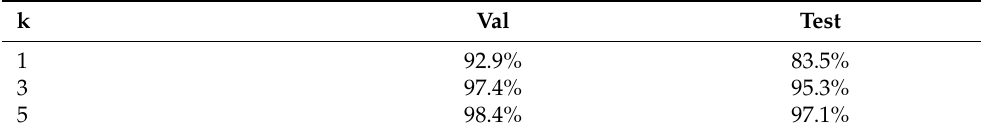
Table 7. Evaluating TunedAraBERT: Top k accuracy.